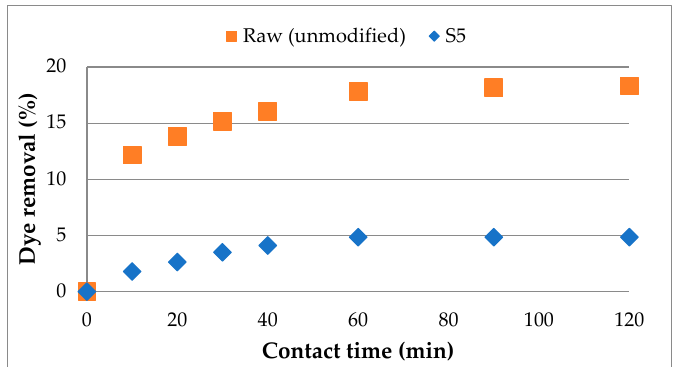
Figure 3. Effect of contact time on dye removal on: (red squares) raw-unmodified and (blue diamonds) S5 rice husks (adsorption conditions are 0.1 g/L Congo red, 25 °C, 10 g/L rice husk).